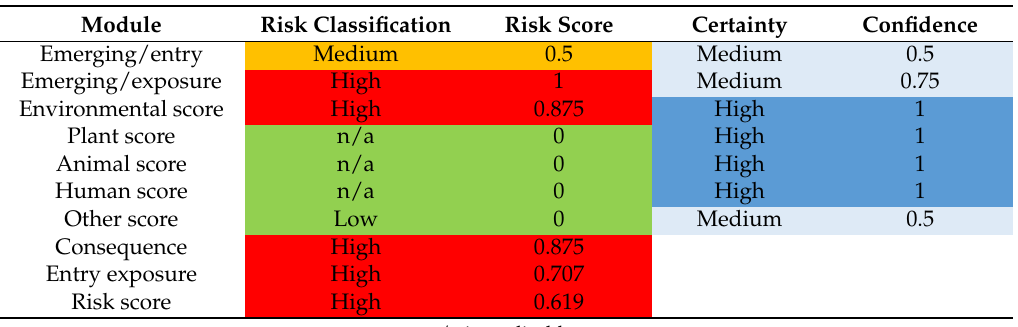
Table 1. Consensus risk classification of frog virus 3 ranavirus in Mexico. The Pandora +